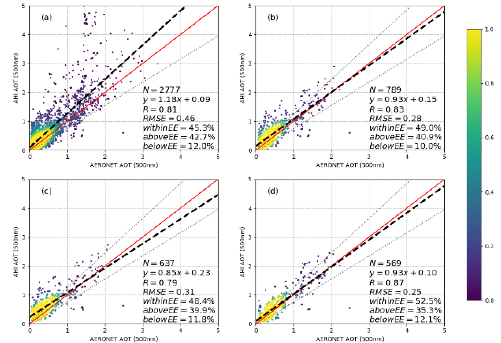
Figure 4. scatter plots of the comparison between the three hourly AOTs and AERONET AOT at 500nm over